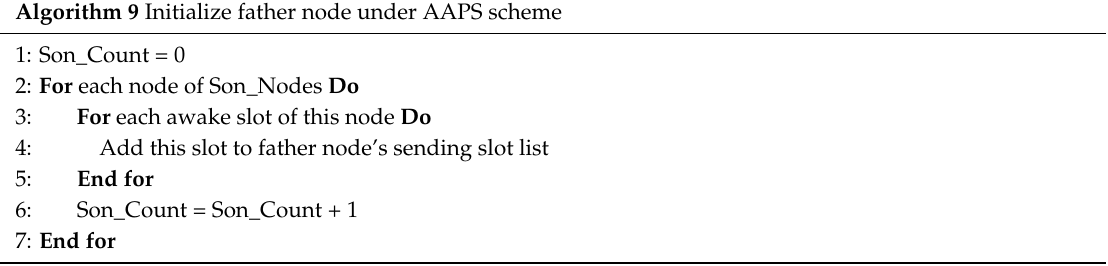
Algorithm 9 Initialize father node under AAPS